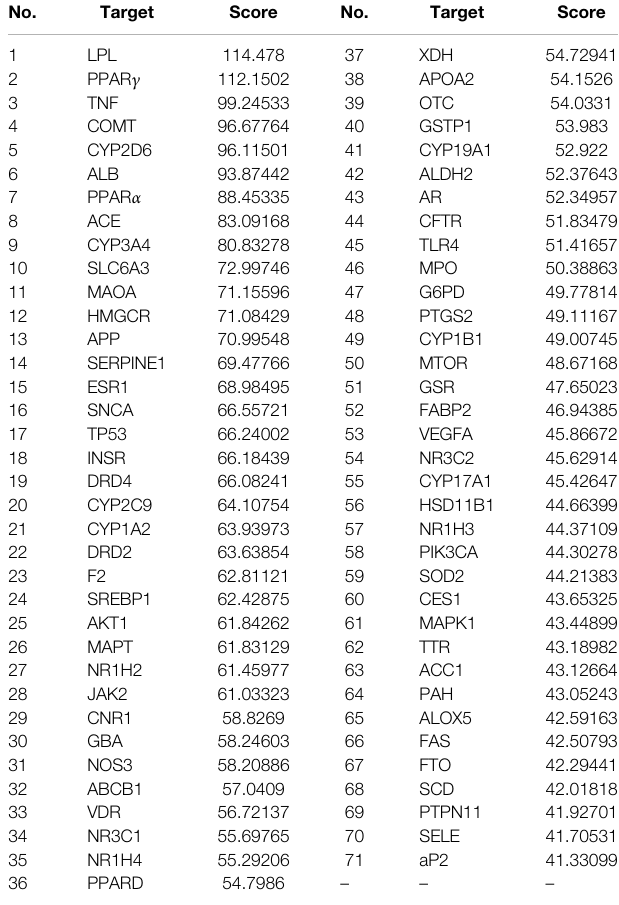
TABLE2| Top71directlyrelevanttargetsof Rubuschingii var. suavissimus inlipid metabolism disorder based on